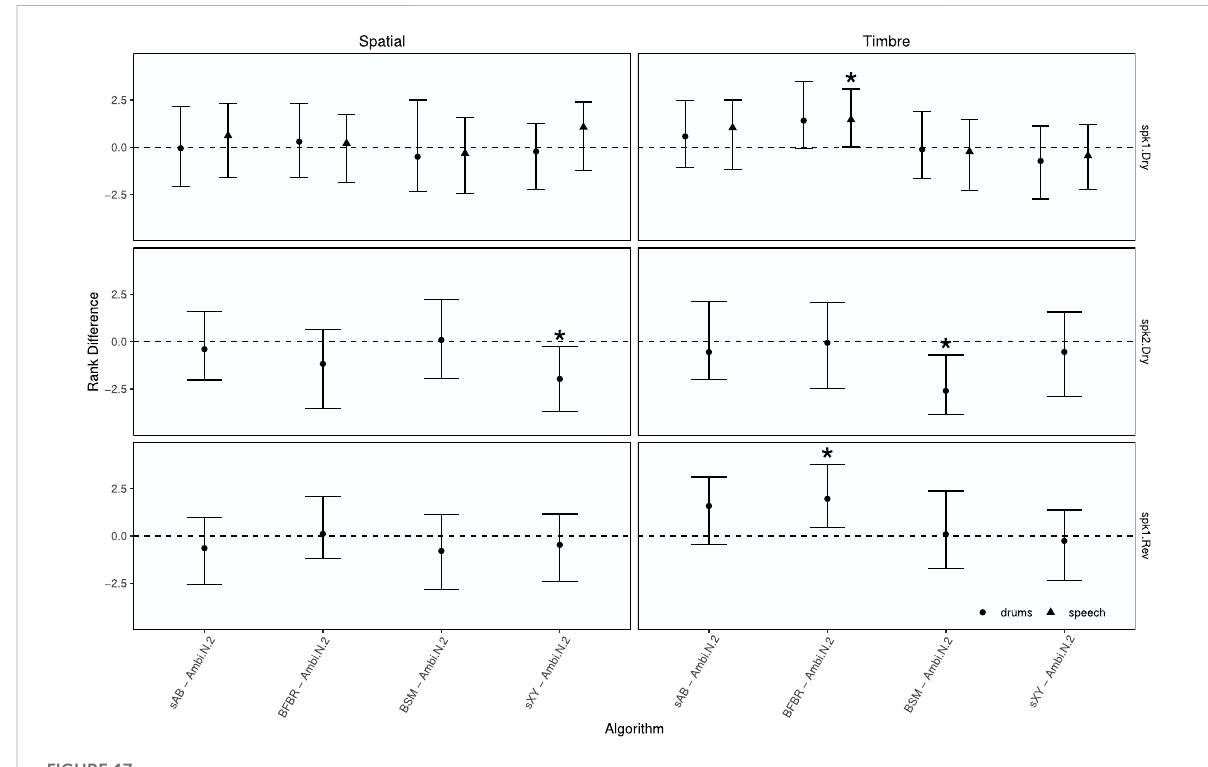
FIGURE 17 EXPERIMENT 2: Median rank differences between renderings and Ambisonics N =2 by attribute, array con fi guration, room, and test signal. Points represent median rank differences and error bars depict the 89% highest density credible interval. Asterisks indicate statistically signi fi cant